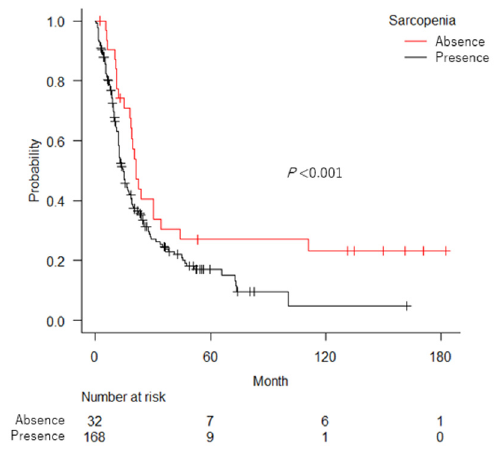
Figure 2. Kaplan–Meier curves of overall survival in patients with advanced urothelial carcinoma according to the presence or absence of sarcopenia.